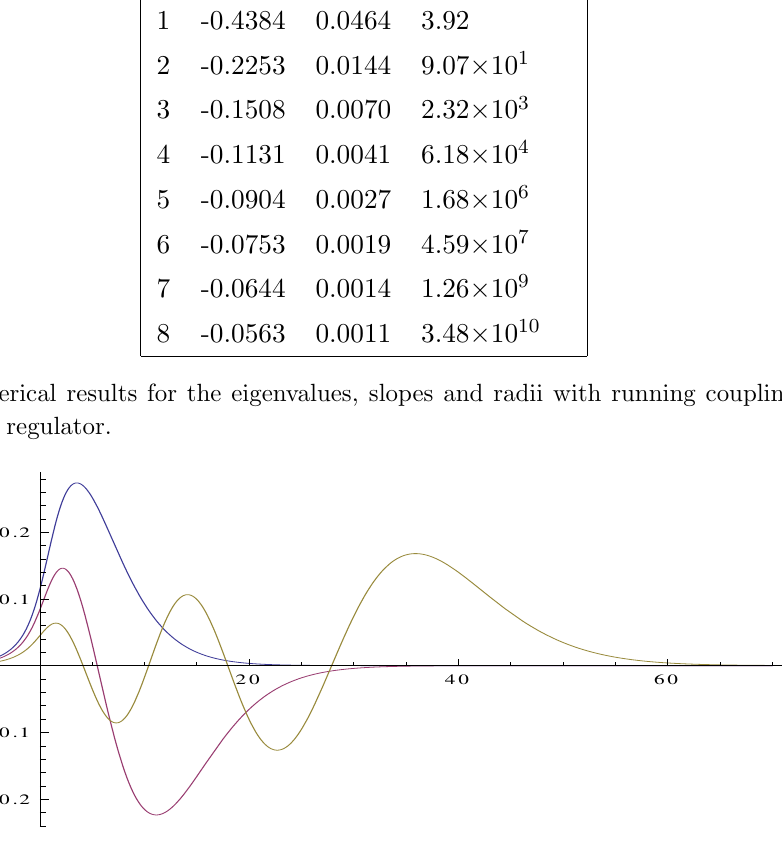
Figure 22 . Three leading wavefunctions (No 1,2,5) as a function of ln q 2